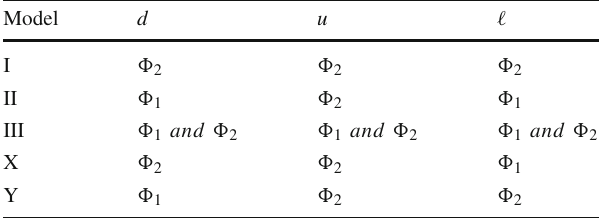
Table 1 The most popular models of the Yukawa interactions in the 2HDM (also referred to as “Types”). The symbols u , d , (cid:12) refer to up- and down-type quarks, and charged leptons of any generation. Here, (cid:4) (cid:4) 1 and 2 refer to the Higgs doublet coupled to the particular fermion. Also other conventions are being used in the literature; see Appendix B